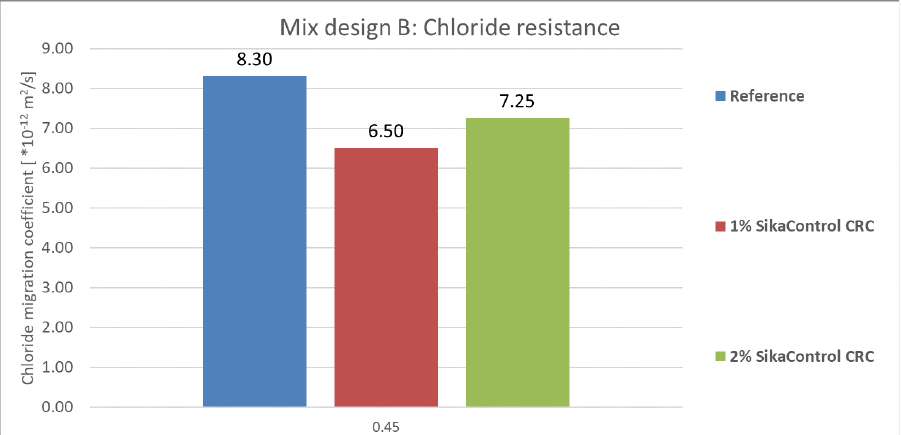
Figure 7. Mix design B: Chloride resistance.